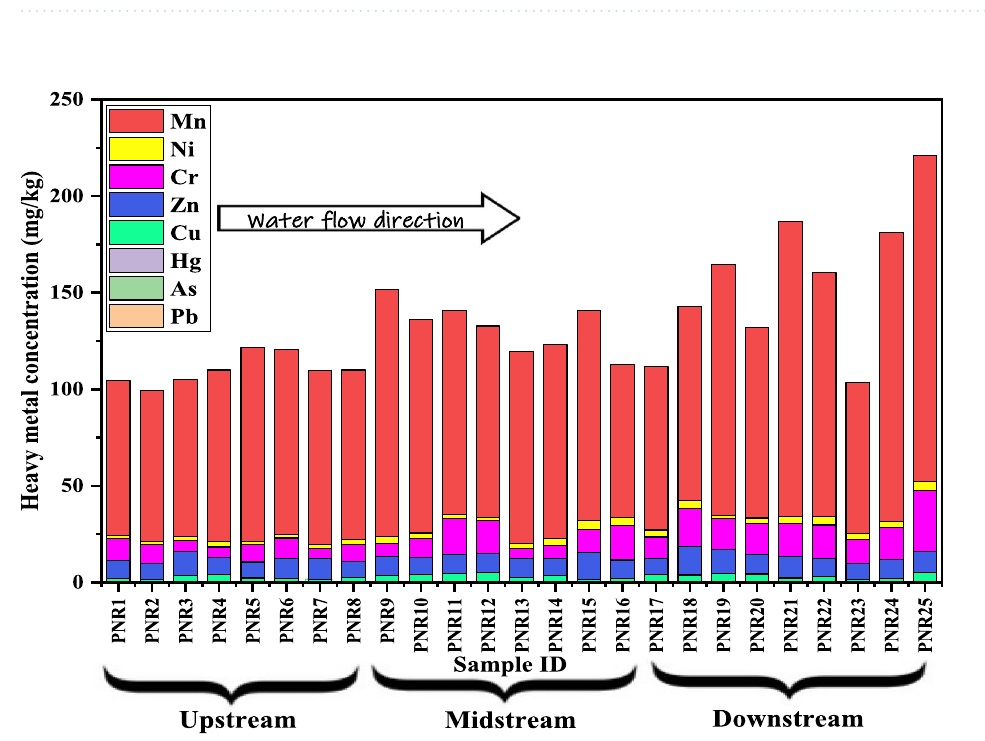
Figure 5. Variation of heavy metal concentration in Ponnai river,